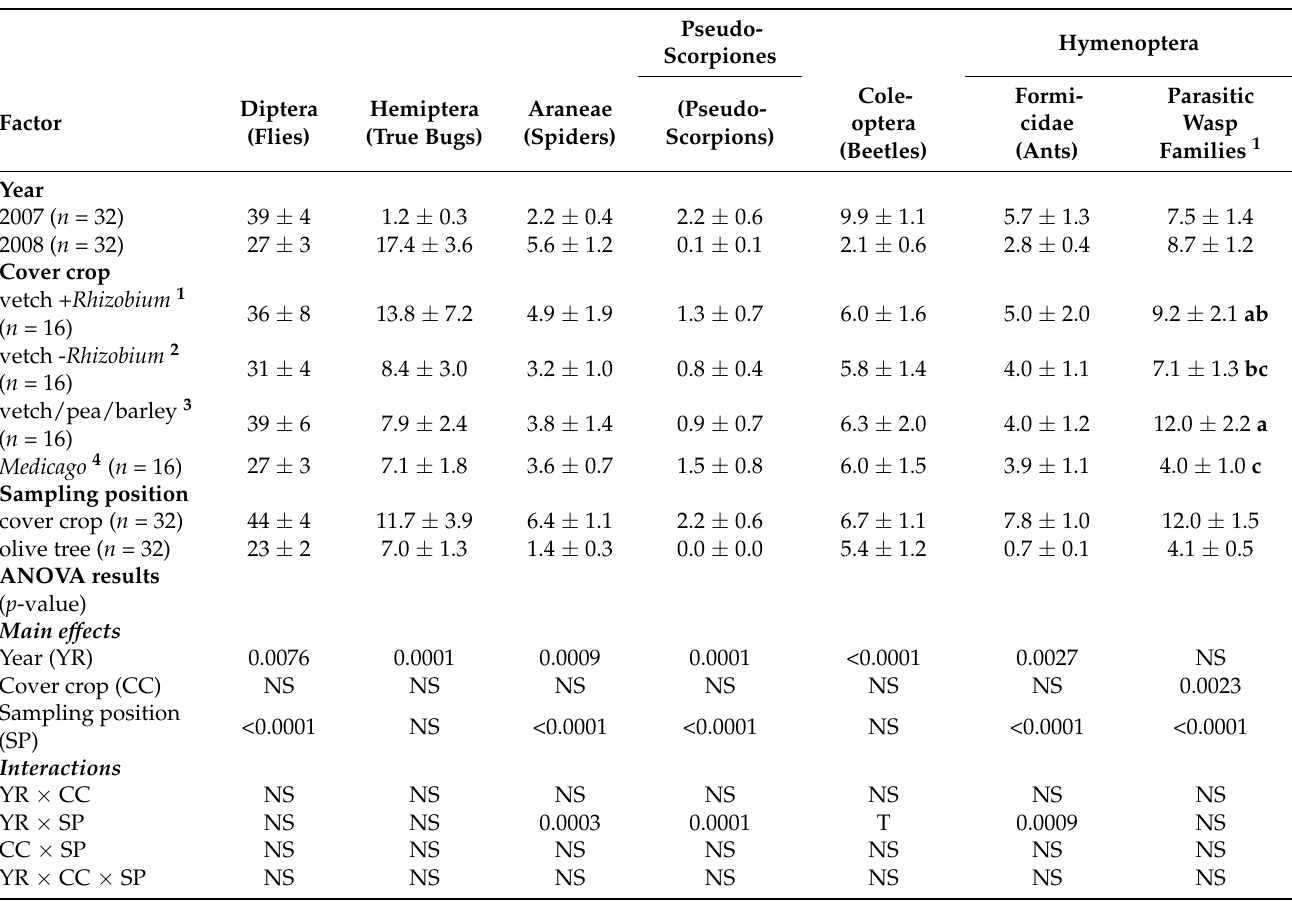
Table 1. Effects of, and interactions between, (a) year (2007 or 2008), (b) cover crop treatment (vetch established with Rhizobium inoculated seed, vetch established with untreated seed, vetch/barley/pea mixture or Medicago), (c) sampling position (cover crop or olive tree canopy) on the activity (mean numbers of invertebrates collected by suction sampling) of major invertebrate groups/orders in table olive cv Kalamon orchards. Values shown are main effect means ±